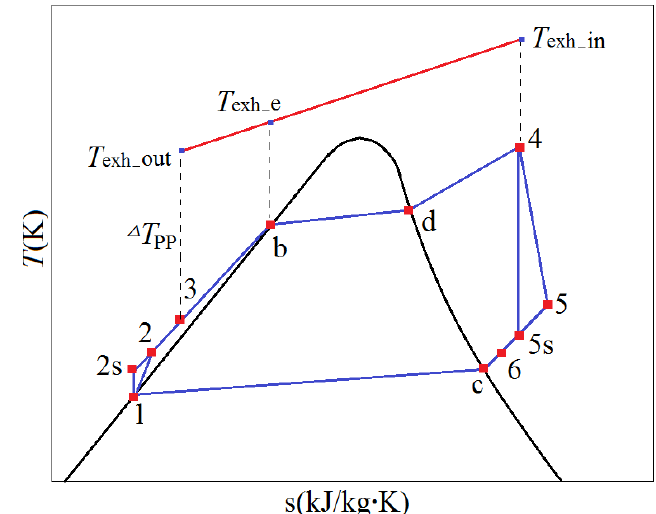
Figure 2. T - s diagram of the ORC waste heat recovery